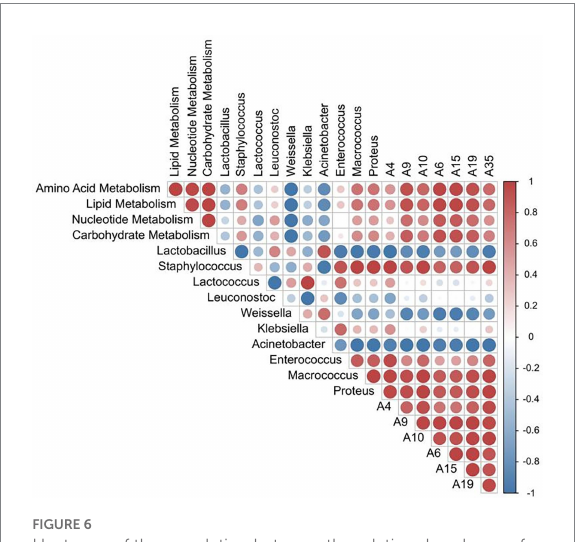
FIGURE 6 Heat map of the correlation between the relative abundance of dominant bacteria, functional metabolic abundance, and differential flavor